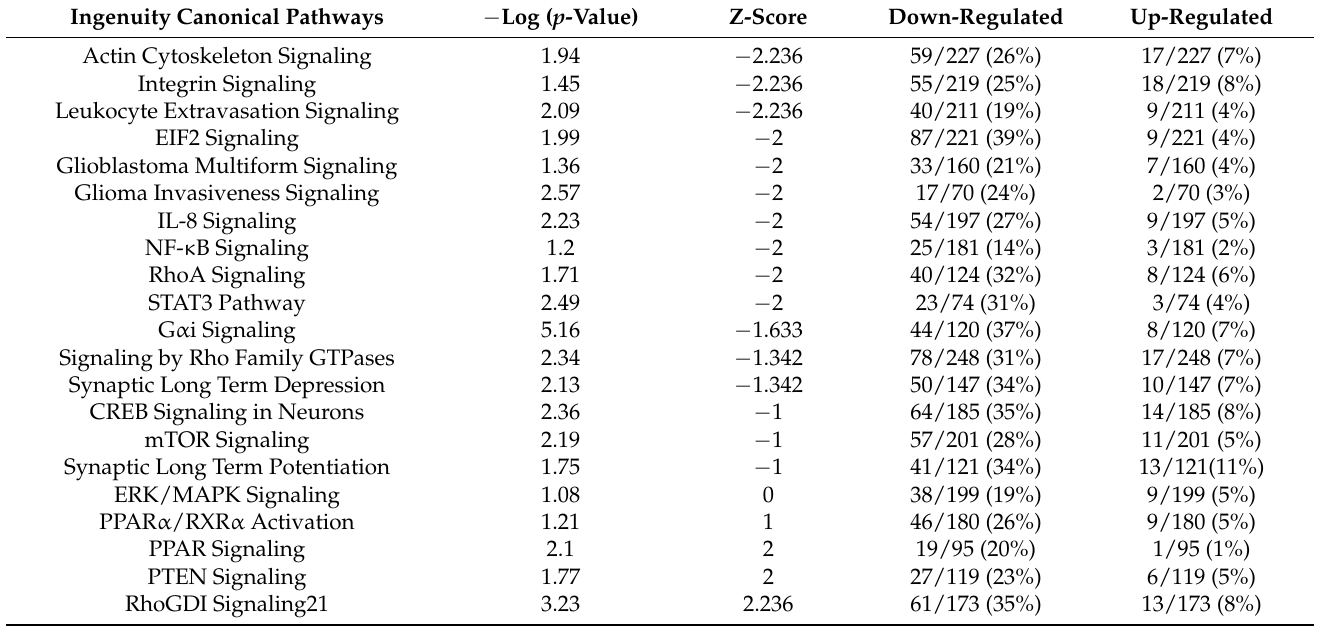
Table 3. Ingenuity Canonical Pathways associated with proteomic changes in retinal MAM with diabetes. Ingenuity Canonical